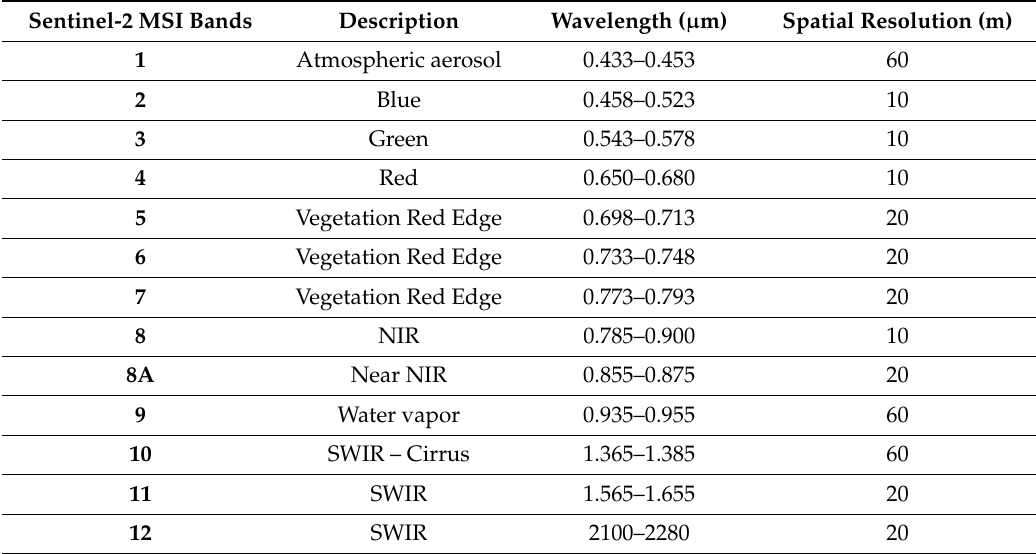
Table 2. Main characteristics of Sentinel-2 MSI bands used in the soil sealing monitoring / mapping